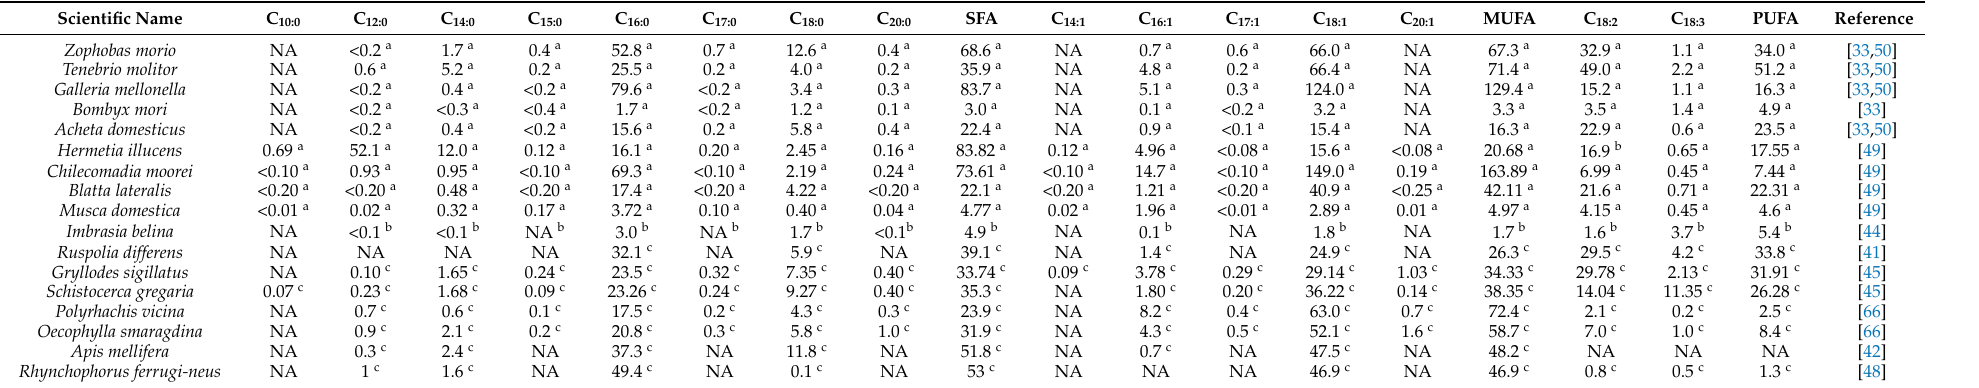
Table 3. Fatty acid composition of insect